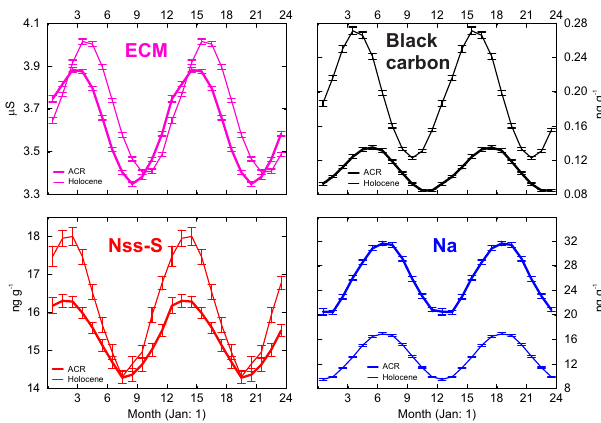
Figure 2. Average annual cycle computed for WAIS Divide ECM record and aerosol records of Na, nssS, and BC for a 1000-year period centred over the early Holocene (10–11ka; thin line) and Antarctic Cold Reversal (ACR; 13–14ka; bold line). Shown are average monthly values for two complete annual cycles assuming constant snowfall distribution throughout the year. The month 0 is equivalent to the position of our annual-layer boundaries (nominal January first), broadly consistent with the minimum in [Na]. Un- certainty bars are 1 σ standard error of the mean. Average WAIS Divide annual-layer thickness for the investigated time intervals is 10.0 ± 1.6cma − 1 (Holocene) and 9.2 ± 1.4cma − 1